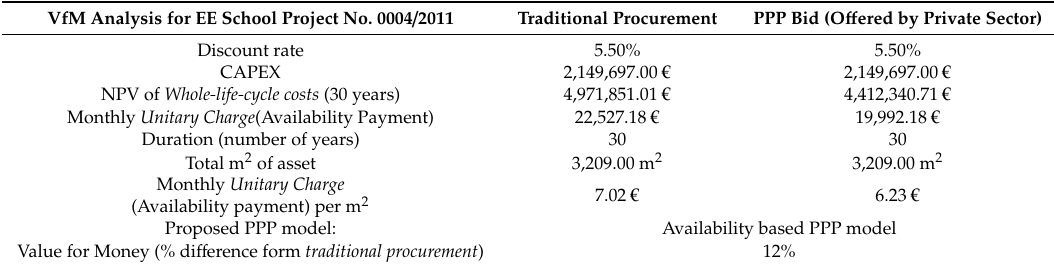
Table A1. Value for Money analysis—data summary. Source: AIK.